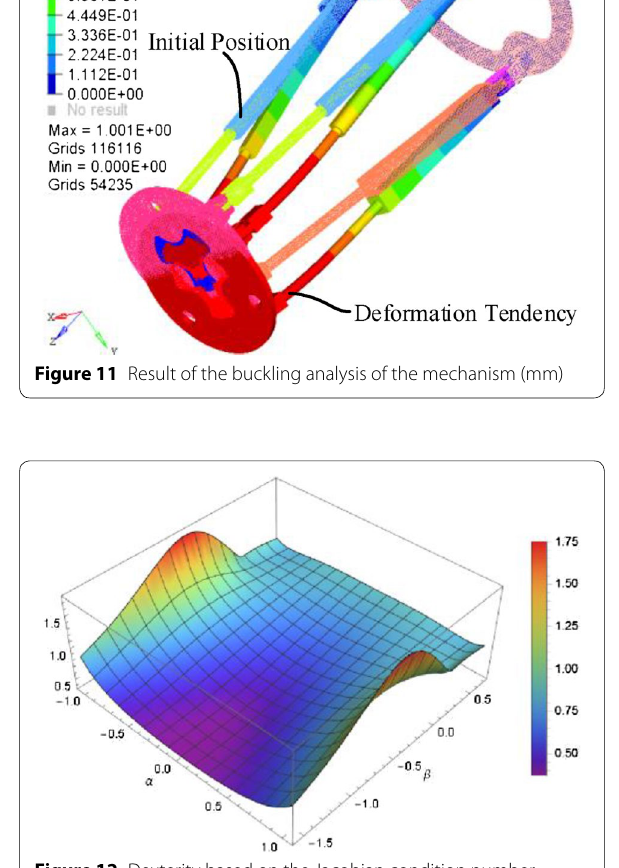
Figure 12 Dexterity based on the Jacobian condition